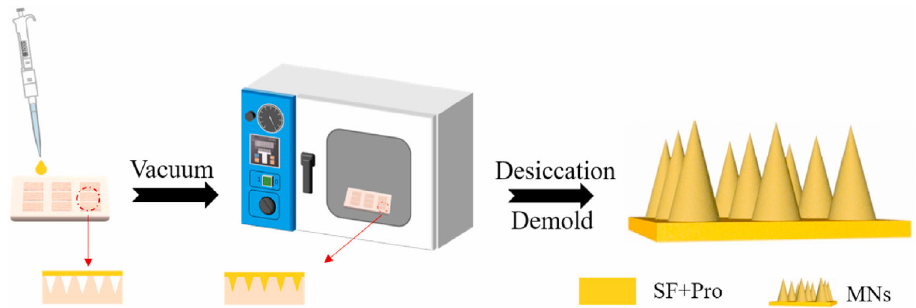
Figure 3. Preparation of microneedles by template pouring. Image used with permission of [86].